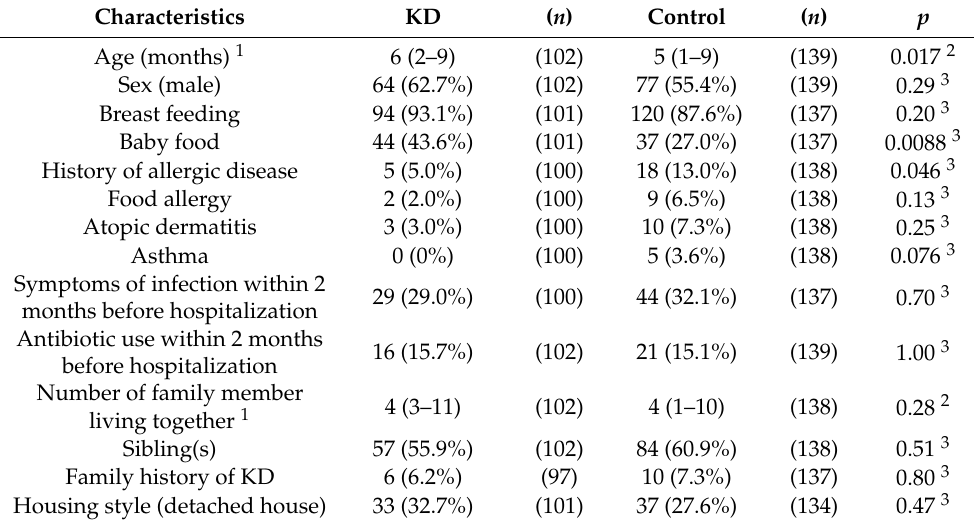
Table 1. Comparison of the background characteristics of the KD patients and